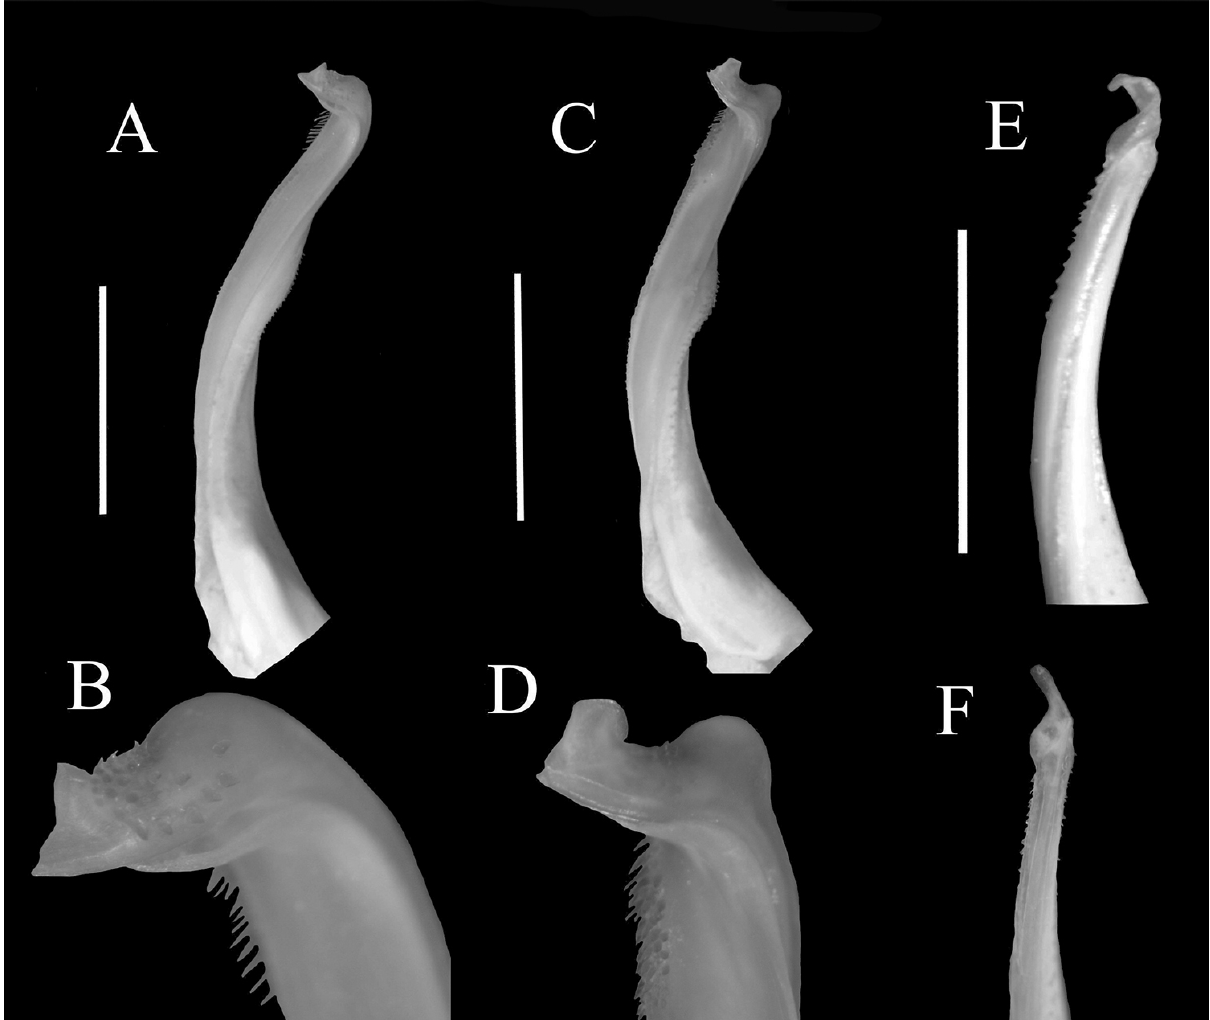
Figure 4. Gonopod 1 (G1) of male specimens: Pseudorhombila octodentata Rathbun, 1906 ( A ), P. octodentata (G1) distal region in detail ( B ), Pseudorhombila quadridentata (Latreille, 1828) ( C ), P. quadridentata (G1) distal region in detail ( D ), Robertsella meridionalis Tavares and Gouvêa, 2013 ( E ), R . meridionalis (G1) distal region in detail ( F ). Scale bar: 0.5